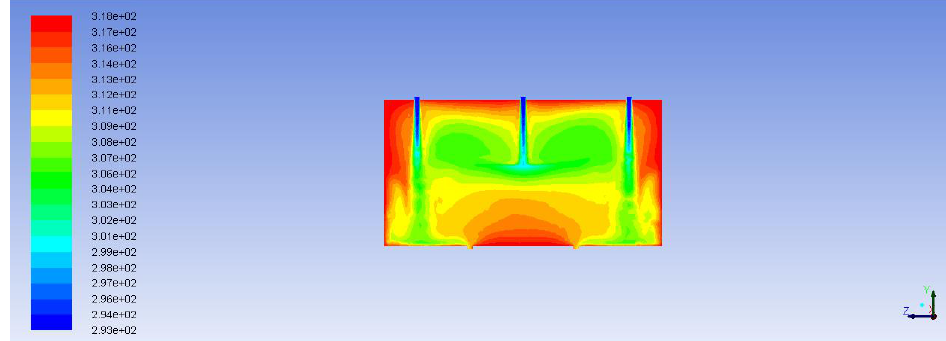
Figure 14. Temperature profile (YZ middle cross section, the reactor walls and the catalyst boundary are not shown, color map is indicated in K units).